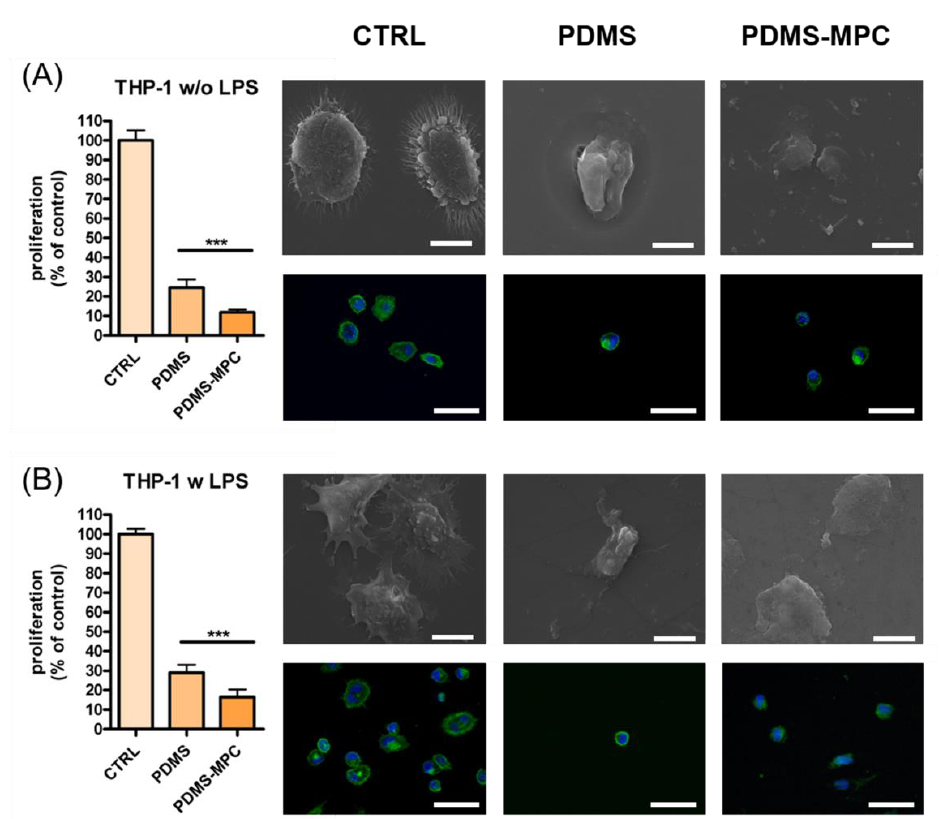
Figure 10. Proliferation, morphology and adhesion of THP-1 macrophages on PDMS scaffolds (without or with pMPC) in the absence ( A ) or presence of LPS ( B ). Cells cultured on glass coverslip served as control (CTRL). MTS data are shown as mean ± standard deviation values of triplicates in each group. *** p < 0.001, * p < 0.05 vs. CTRL, • p < 0.05 vs. PDMS surface. Representative fluorescence microscopy images of THP-1 cells cultured on all surfaces (objective 40×). Cells were labelled for actin (green) and nuclei (blue). Scale bar: 50µm. Representative SEM microscopy images of THP -1 cells’ morphology on surface materials were at 5000× magnification (Inspect S Electron Scanning Microscope). Scale bar: 10 µm.